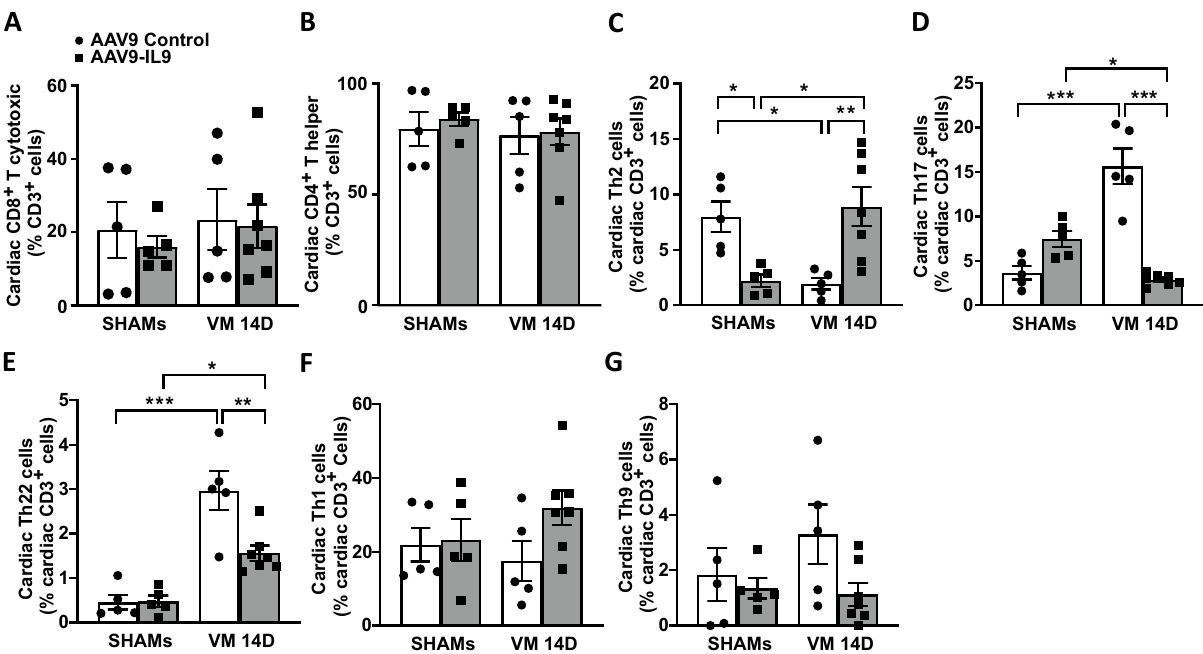
Figure 7. IL9 overexpression alters T helper subpopulations, enhancing Th2 and reducing Th17/22 presence in the acute phase. ( A ) T cytotoxic and ( B ) T helper lymphocytes detected by flow cytometry in IL9-overexpressing hearts and controls at 14 days post-infection. Significance assessed by two-way ANOVA, followed by Tukey’s test. ( C ) T helper 2 lymphocyte (Th2), ( D ) Th17, ( E ) Th22, ( F ) Th1, and ( G ) Th9 cardiac subpopulations detected by flow cytometry in CVB3-infected IL9-overexpressing hearts and infected controls at 14 days post- infection. Significance assessed by two-way ANOVA followed by Tukey’s test or by Kruskal–Wallis test ( F ), with *p ≤ 0.05, **p ≤ 0.01, ***p ≤ 0.001. All values are expressed as mean ±